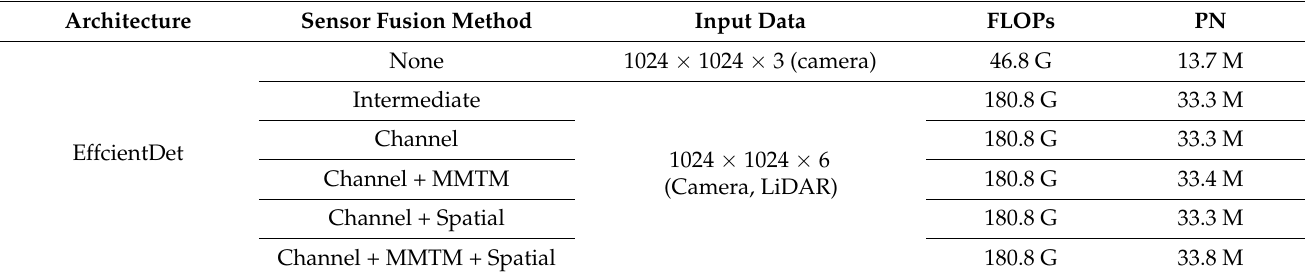
Table 4. Comparisons of model size and complexity. FLOPs: floating-point operations., PN: parameter number.